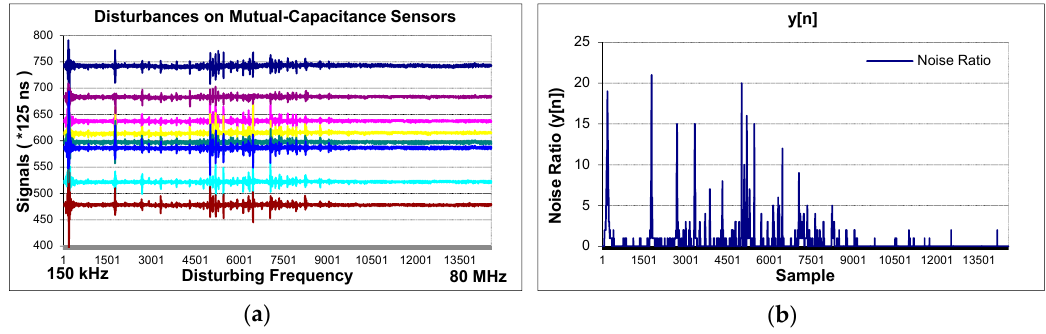
Figure 7. ( a ) Signals are received from 8 channels when the noise being injected differs between 150 kHz and 80 MHz; ( b ) the output of the noise detection algorithm.